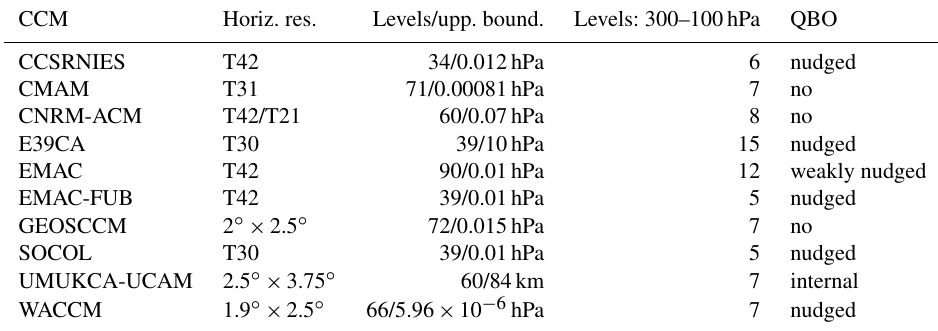
Table 1. Main characteristics and specifications of the chemistry–climate models used. More comprehensive information can be found in Morgenstern et al. (2010). CCM Horiz. res. Levels/upp. bound. Levels: 300–100hPa QBO CCSRNIES T42 34/0.012hPa 6 nudged CMAM T31 71/0.00081hPa 7 no CNRM-ACM T42/T21 60/0.07hPa 8 no E39CA T30 39/10hPa 15 nudged EMAC T42 90/0.01hPa 12 weakly nudged EMAC-FUB T42 39/0.01hPa 5 nudged GEOSCCM 2 ◦ × 2.5 ◦ 72/0.015hPa 7 no SOCOL T30 39/0.01hPa 5 nudged 60/84km 7 internal 66/5.96 × 10 − 6 hPa 7